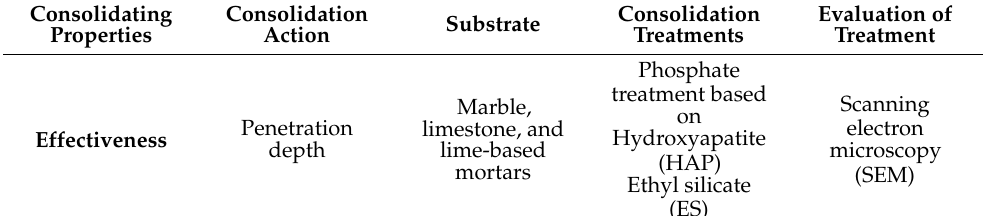
Table 2. Properties of representative consolidants and methods of evaluation for stone conservation